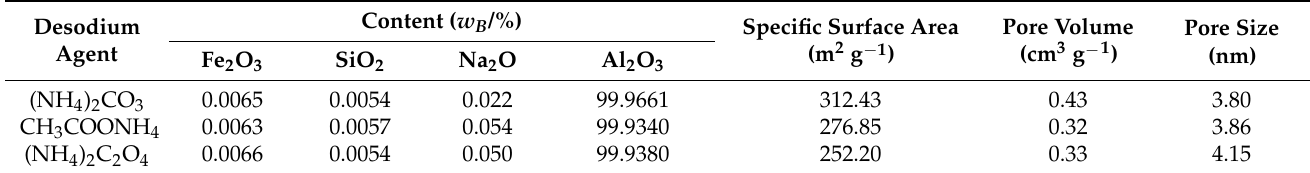
Table 6. Effect of ammonium salt type on the impurity mass, alumina purity and porosity the product alumina.